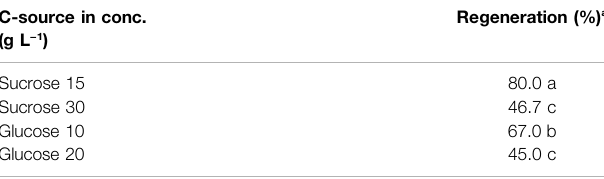
TABLE 5 | Effect of C-source in SIM medium on shoot regeneration of fi eld cress.